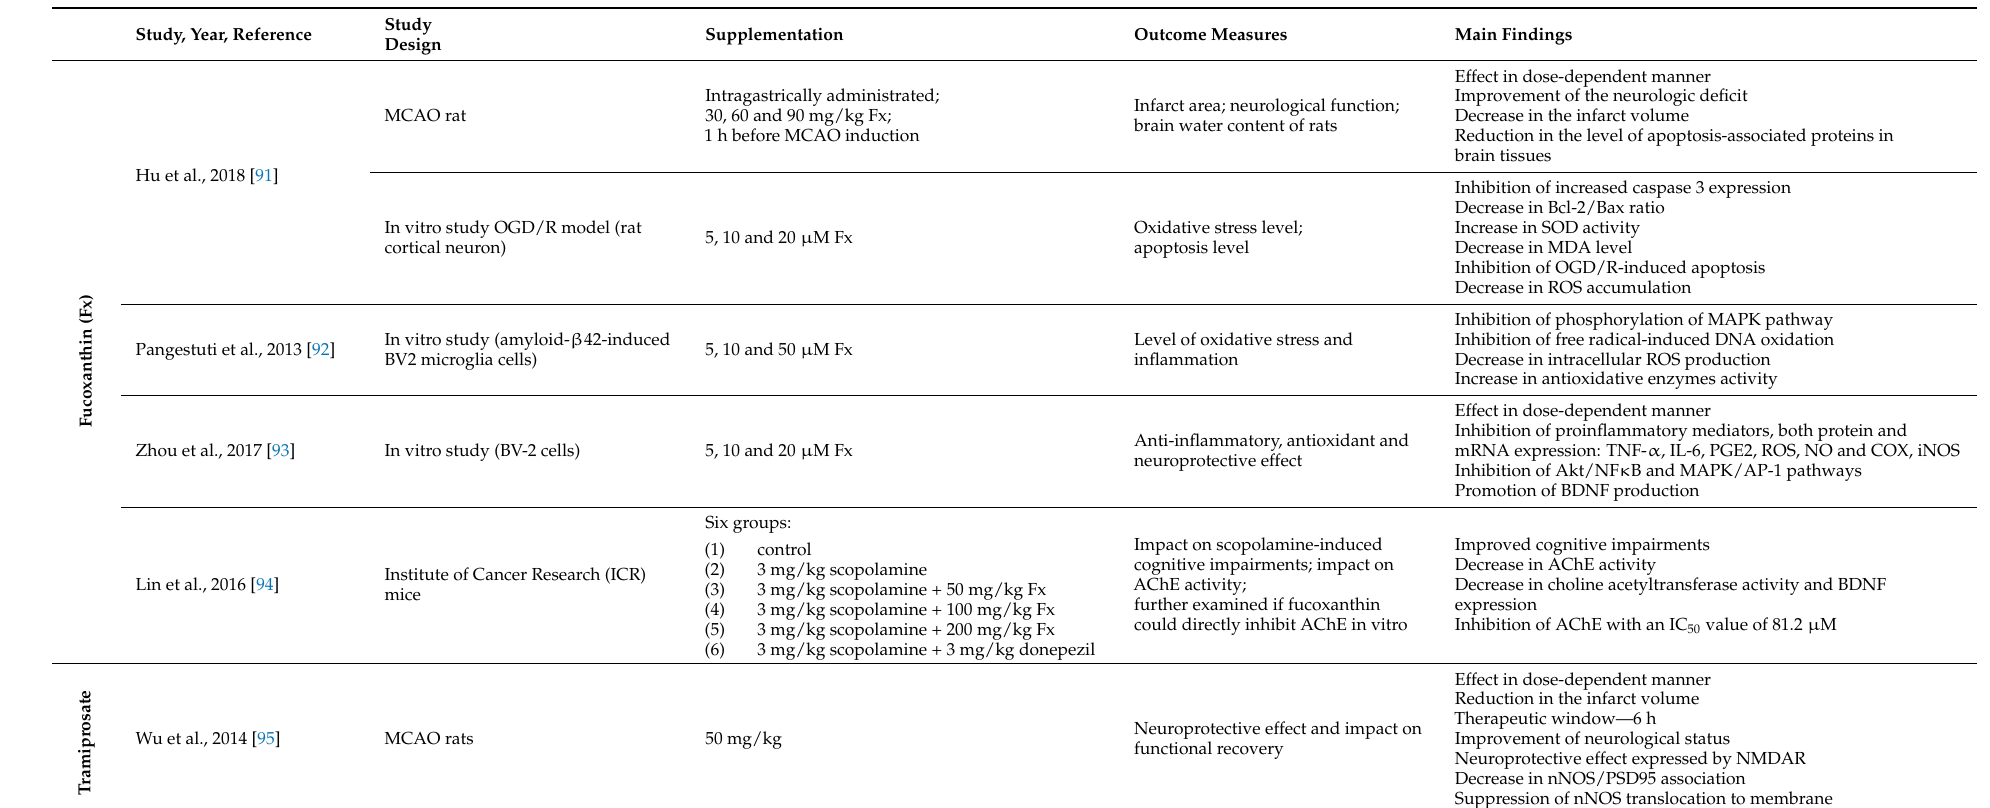
Table 3. Neuroprotective action of compounds from marine